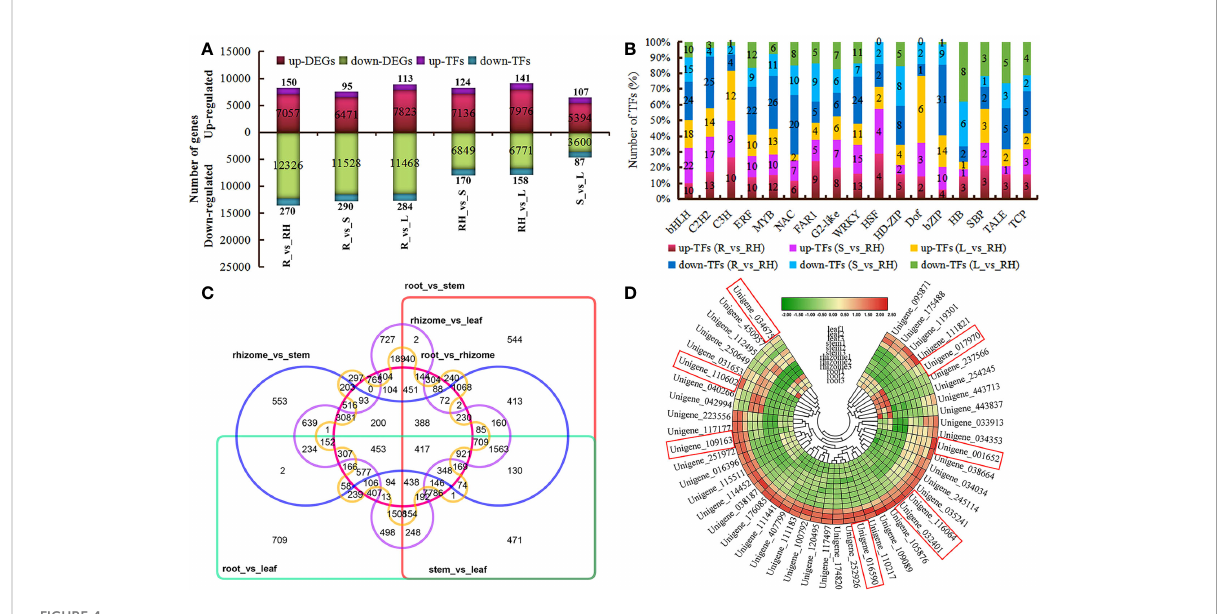
FIGURE 4 Differential gene expression by pairwise comparison. (A) Statistics of up- and downregulated unigenes or TFs. (B) The number of genes from different TF families showing up- or downregulation at different tissues. (C) Venn diagram of DEGs shared among all groups. (D) Heatmap showing DEGs involved in terpenoids and fl avonoids in the leaf compared with the